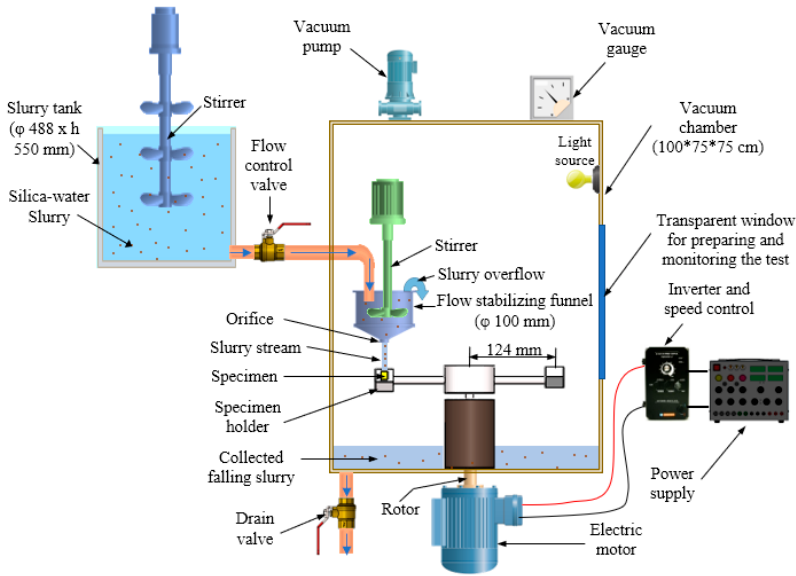
Figure 4. Schematic view of the slurry whirling-arm rig.